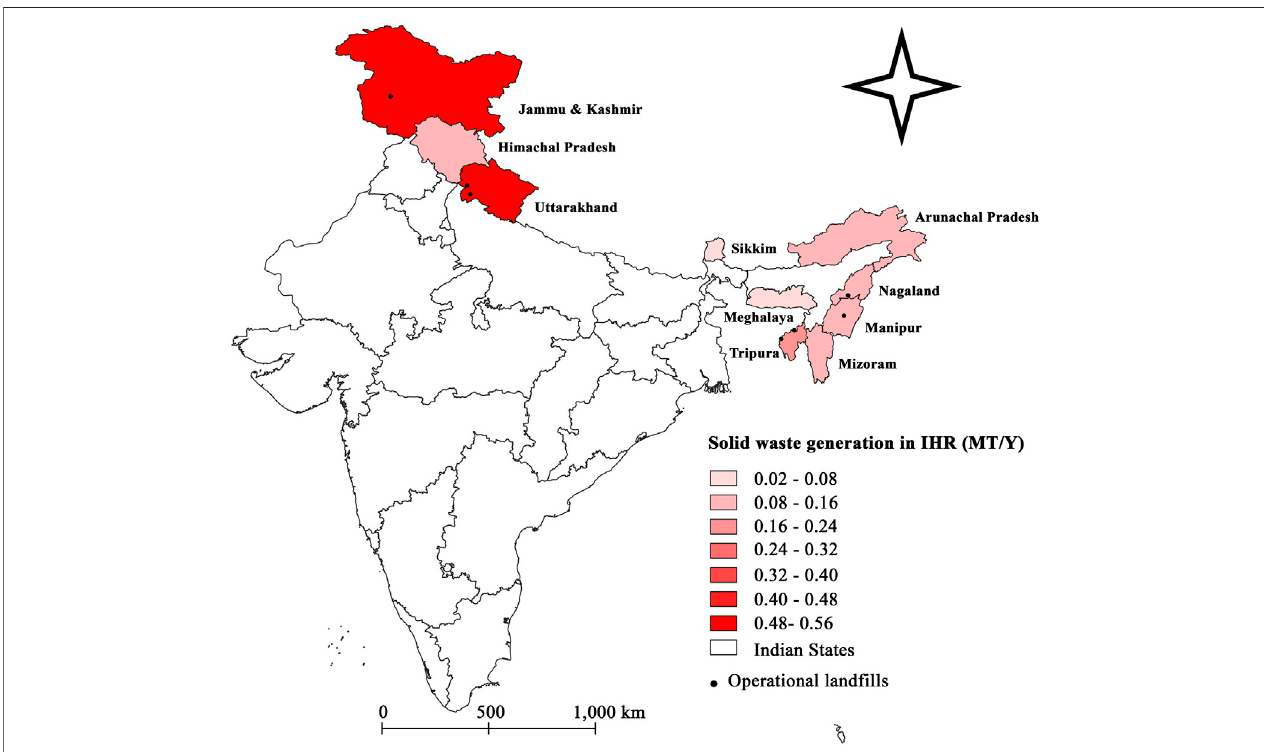
FIGURE 1 | The state-level estimate of total solid waste generated in the IHR. The map shows the kernel density estimate of the amount of waste generated in the IHR,usingQGIS 3.12.3. In2018 – 2019,1.905MT/Ysolidwaste wasgenerated,outofwhichamere0.263MT/Ywasreportedtobeland fi lled.Till2019,therewereonly six operational land fi lls in the IHR (Data source: CPCB,